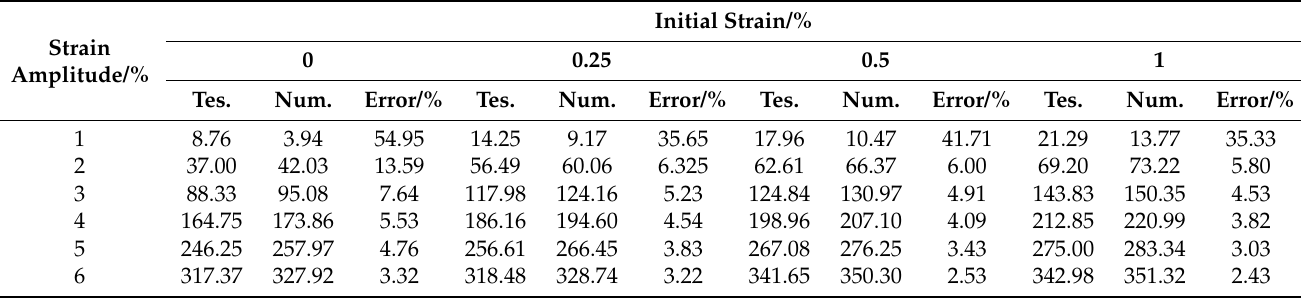
Figure 15. ( a ) SCB-12-0; ( b ) SCB-12-25; ( c ) SCB-12-50; ( d ) SCB-12-100. Comparison between test and numerical hysteresis curves under different initial strains. Table 9. Comparison of energy dissipation capacity under different initial